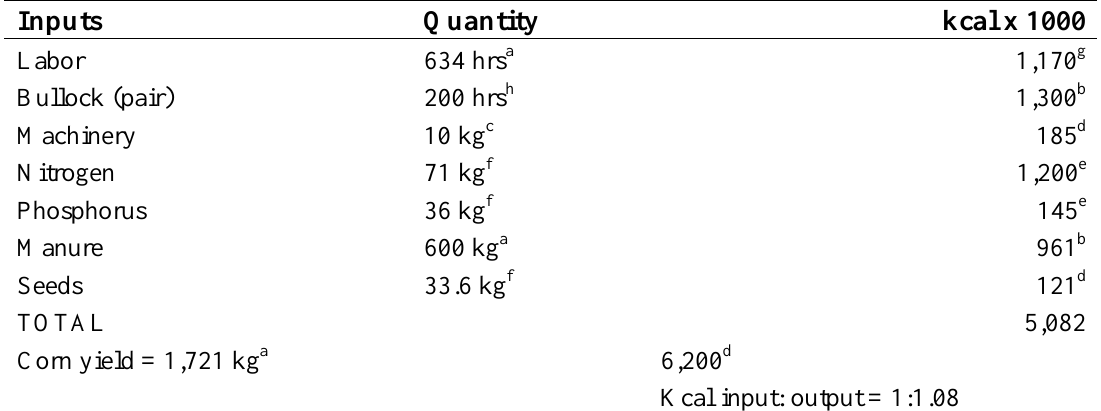
Table 4. Energy inputs of corn production per hectare in India and